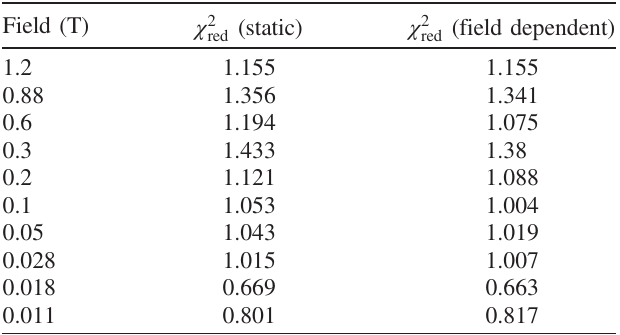
TABLE III. Reduced χ 2 values for refinement of the field- dependent SANSPOL data according to either a static or a field- dependent magnetic morphology model. Fit results are shown in Figs. 3 and 13,